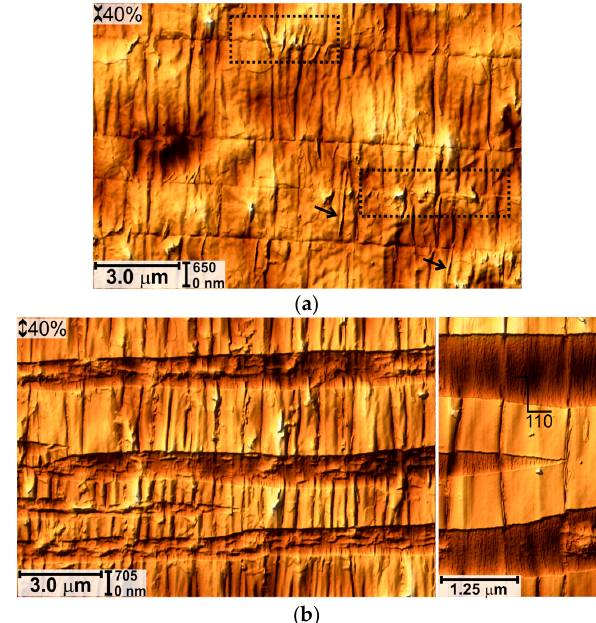
Figure 8. AFM images of PU after the PIII 1-17 and fatigue loading to 40% in the unloaded ( a ) and stretched ( b ) state. In ( a ) the polymer squeezed out from the cracks is marked by rectangles and arrows. In ( b ) the height of crack edge is shown (in nm).